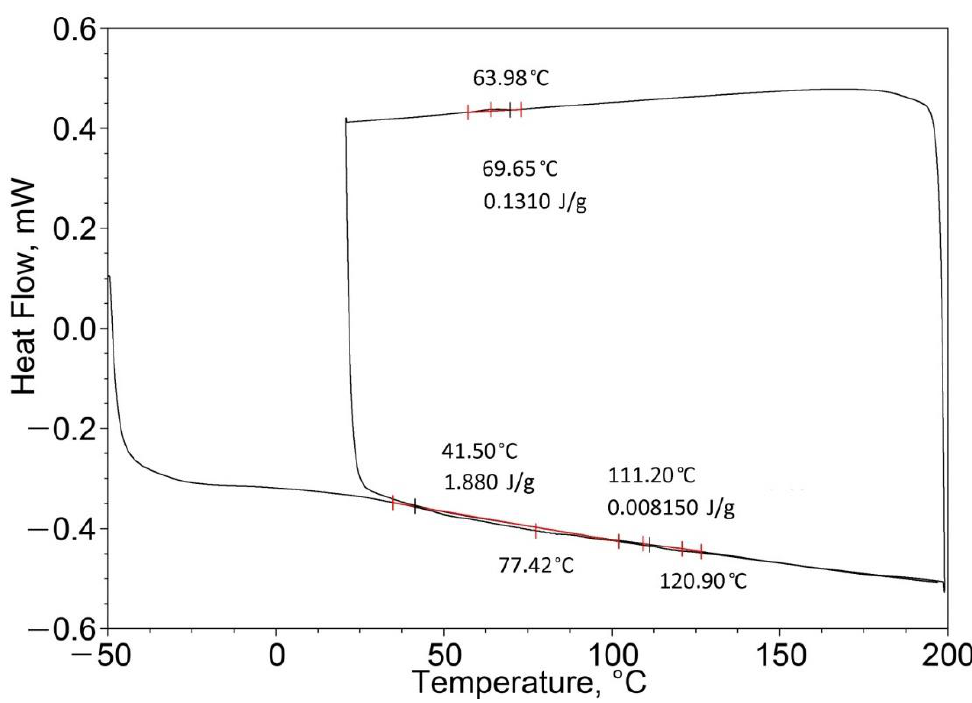
Figure 9. DSC scan curves (DSC thermograms); melting-crystallization-melting diagram of the initial pure EPTSR-50 polymer sample .